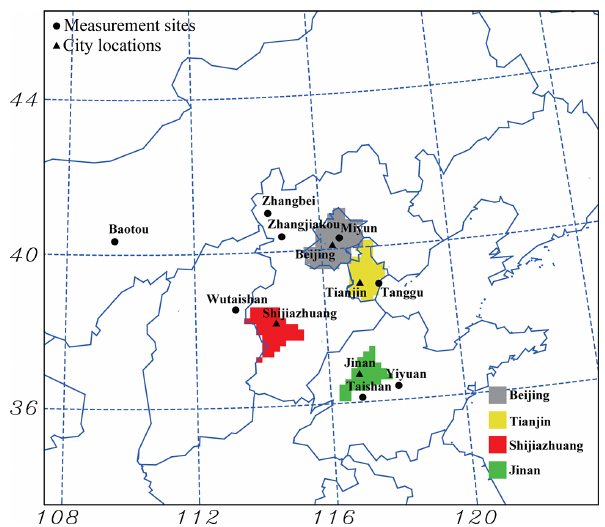
Figure 1. Geographic location of CRAES monitoring cities and CNMC measurement stations in the model domain. The gray, yellow, red, and green areas represent the districts of Beijing, Tianjin, Shijiazhuang, and Jinan,